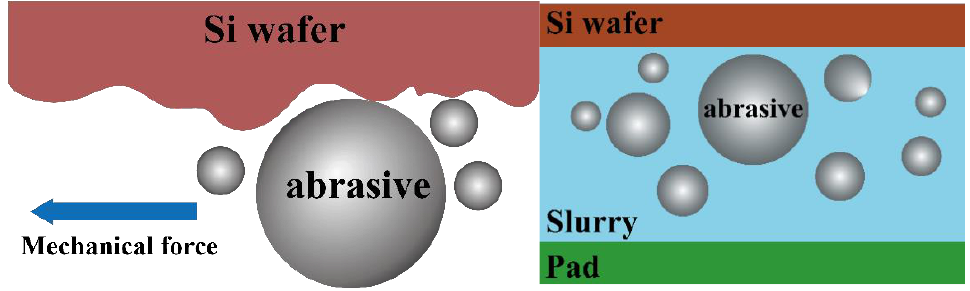
Figure 1. Schematic diagram of the mechanical effect of abrasives.